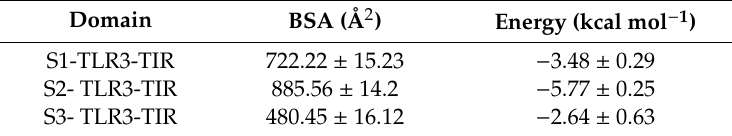
Table 5. Buried surface area (BSA) and interface energy ( ∆ iG) of TIR domains in the full-length TLR3.